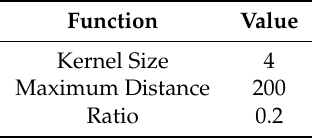
Figure 8 is the output after computing the super-pixels on a sample chest CT scan image.